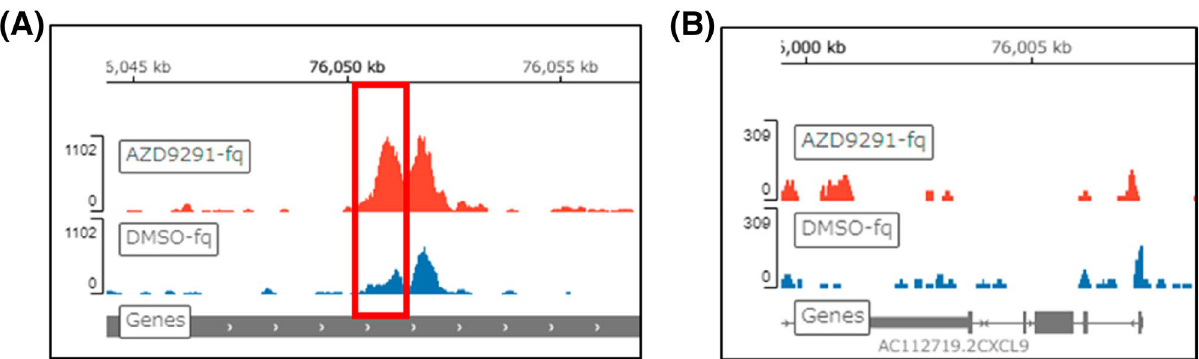
Figure 5. Oncogenic EGFR signaling suppressed histone H3K27 acetylation at 15 kb upstream of CXCL11 TSS, which corresponded to the open chromatin peak by ATAC-seq. Histone H3K27 acetylation peaks are represented in Integrative genomic view (IGV). ( A ) Red histogram (AZD9291-treated) showed a significantly higher peak than blue histogram (DMSO-treated) at chr4:76,050,566–76,051,369 (p = 10 –31 , q = 10 –25 ) (red rectangle), which overlapped to the open chromatin peak by ATAC-seq at chr4: 76,051,000–76,052,100. ( B ) Histone H3K27 acetylation peak in the 1st intron of CXCL9 (chr4: 76,007,200–76,007,500) did not show significant difference between AZD9291 and